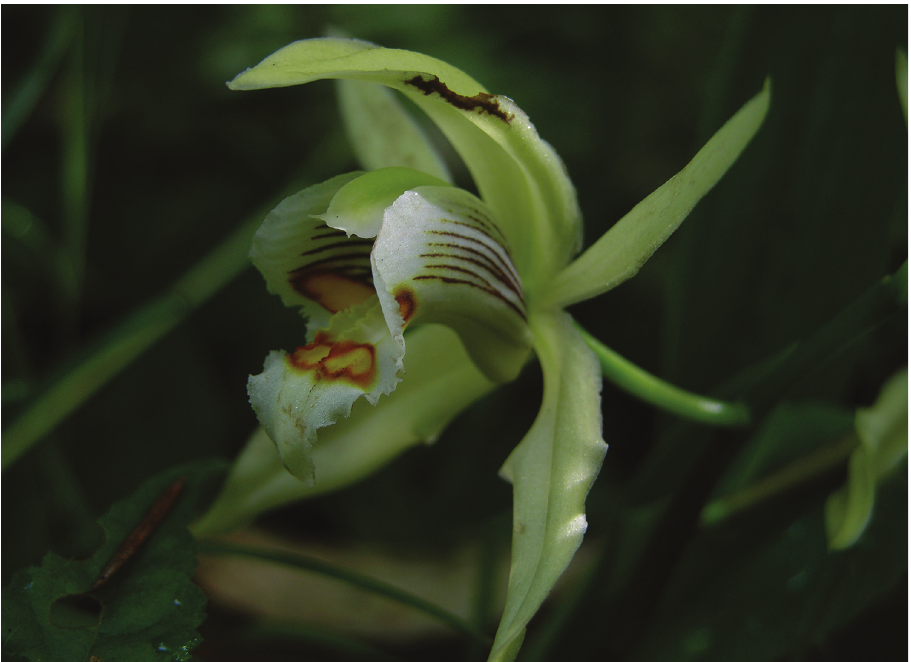
Figure 5. Close-up of flower of Coelogyne taronensis . Photo by X.H.